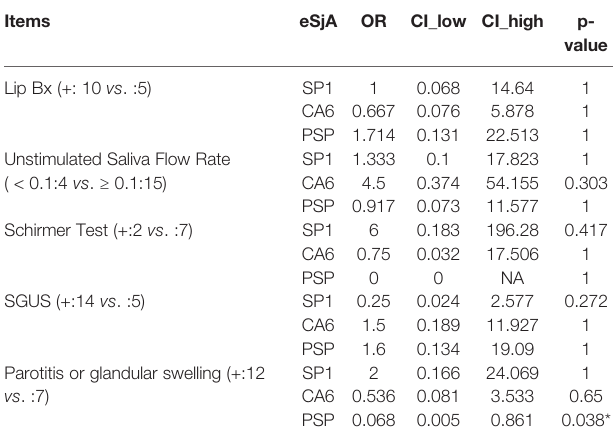
TABLE 4 | Association between diagnostic/glandular items and eSjA in SSA- positive subjects. Items